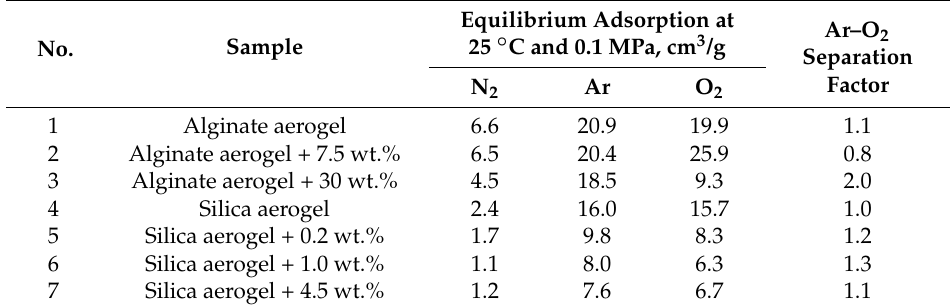
Table 3. Equilibrium quantities of adsorbed nitrogen, oxygen, and argon for hybrid aerogels with embedded